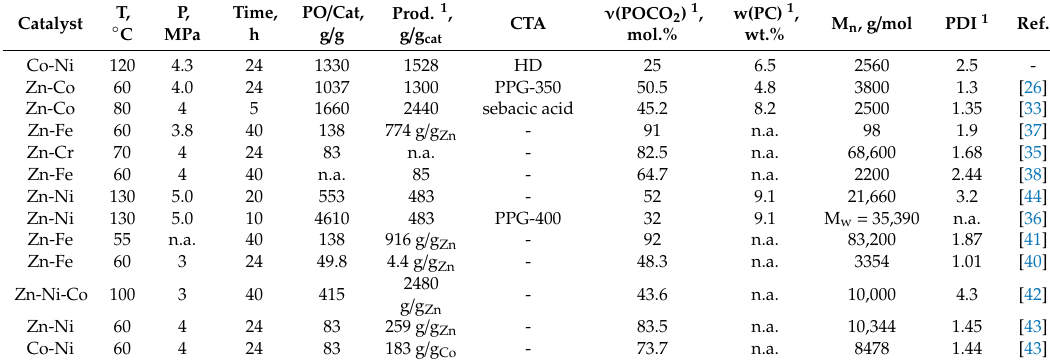
Table 5. Comparison of the performance of Co-Ni(0) with the performance of other metal cyanide